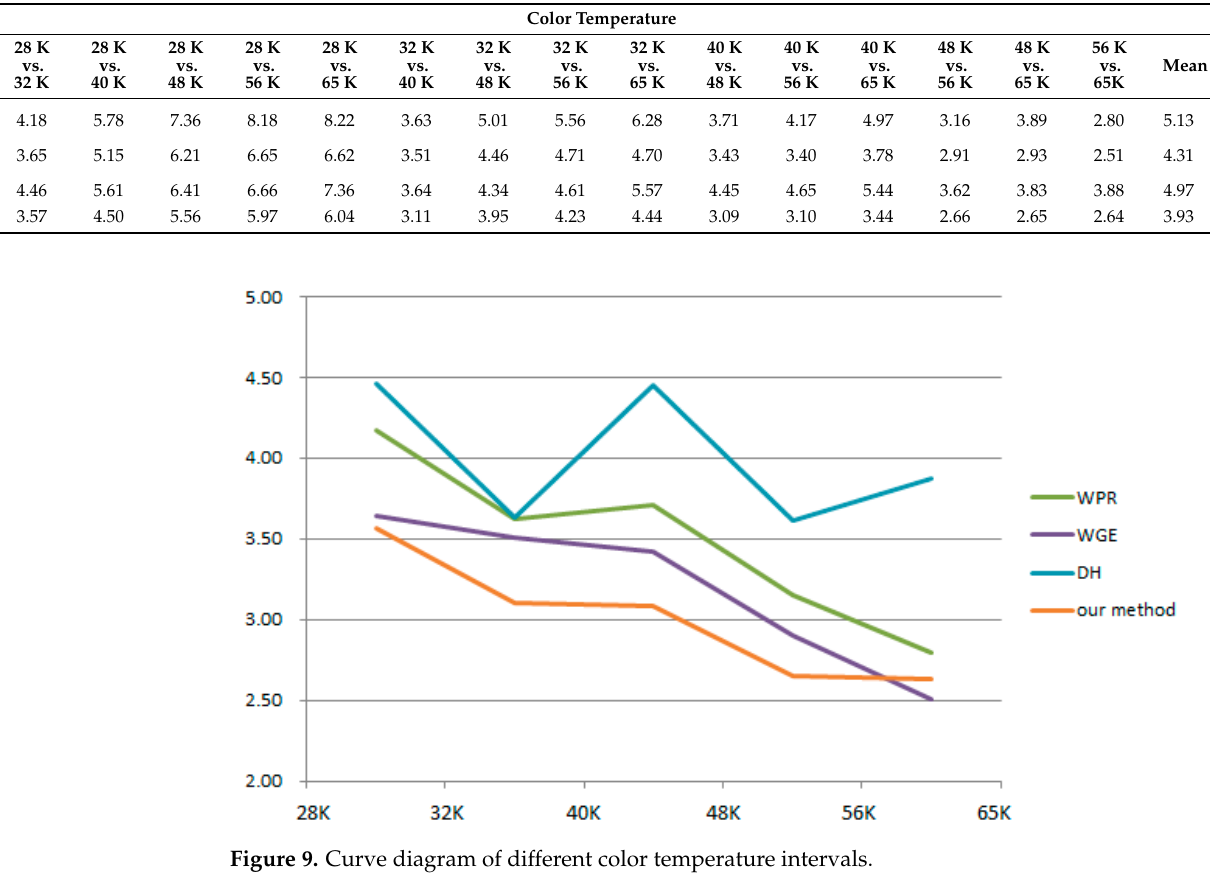
Table 3. The results of CIEDE2000 among WPR [27], WGE [28], DH [25], and our methods.